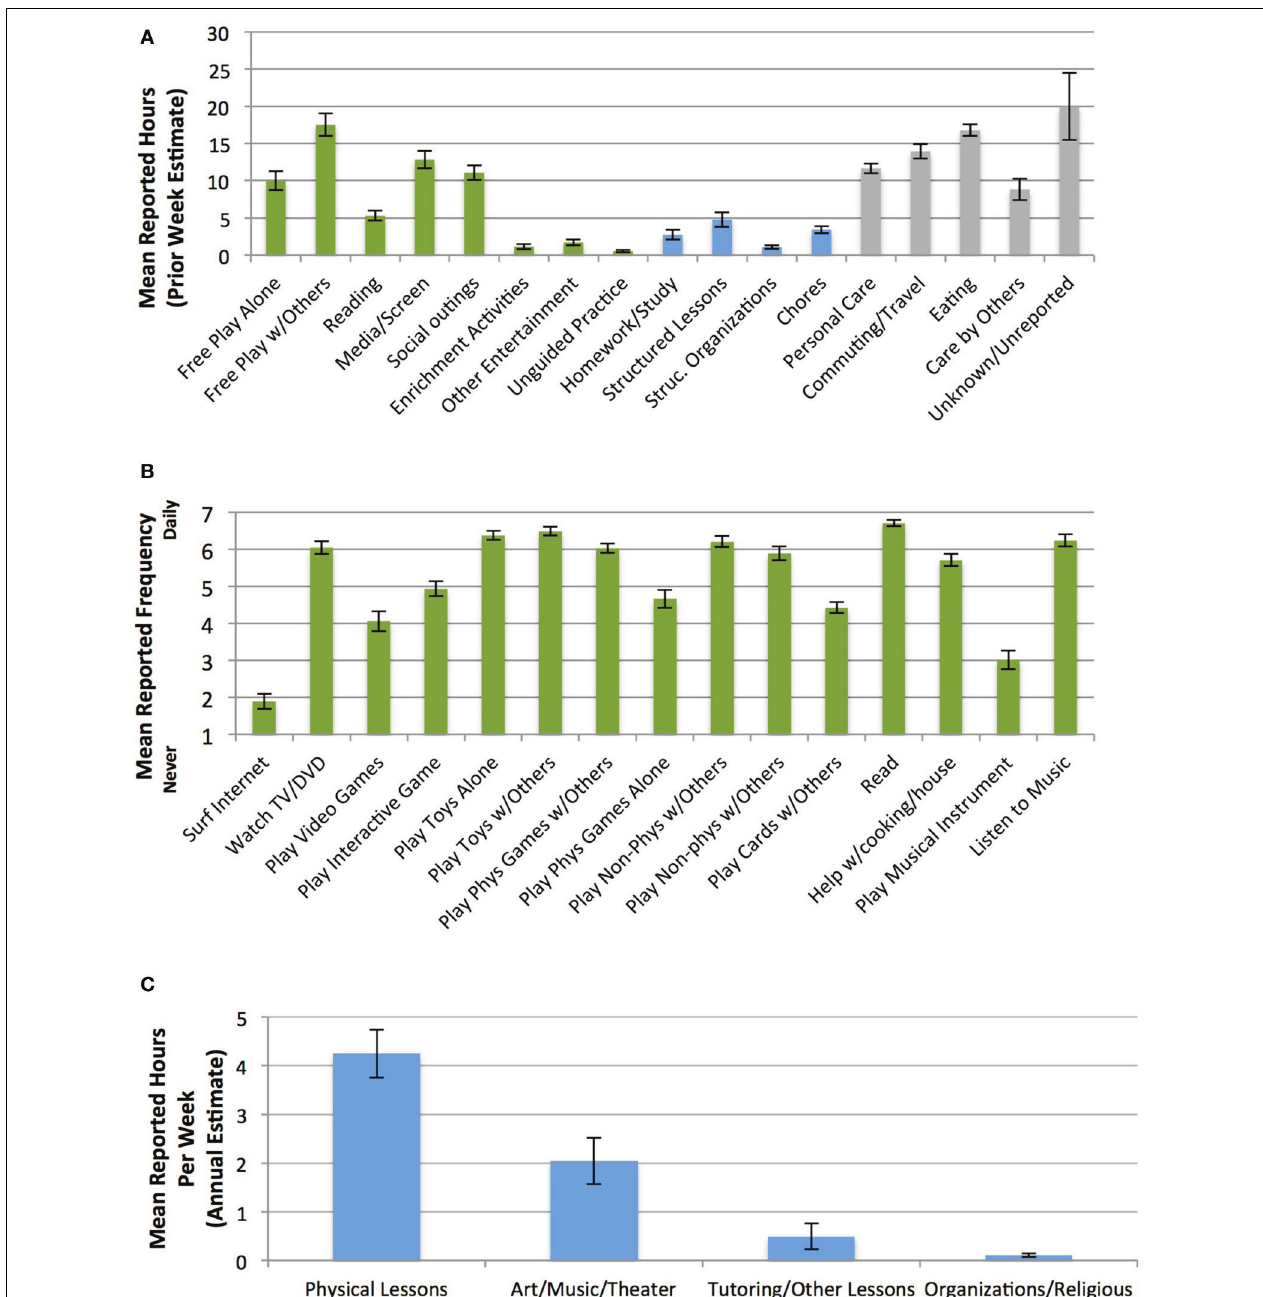
FIGURE 1 | Parent-reported child time use. (A) Activities in week prior to laboratory visit (green, less-structured; blue, structured; gray, other). (B) Typical less-structured activities (1, Never; 2, Less than once a month; 3, Once a month; 4, 2–3 times a month; 5, Once a week; 6, 2–3 times a week; 7, Daily). (C) Typical structured activities during a